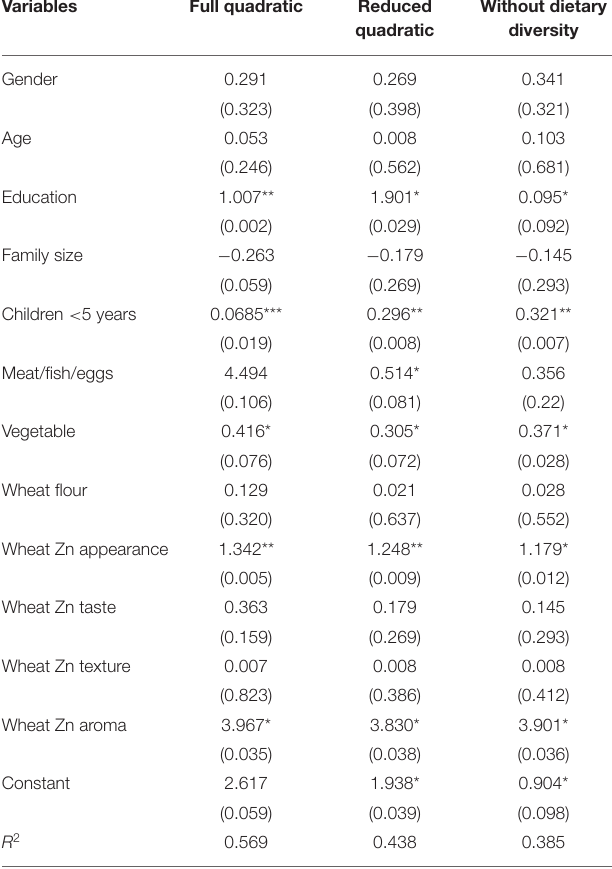
TABLE 3 | Probit model